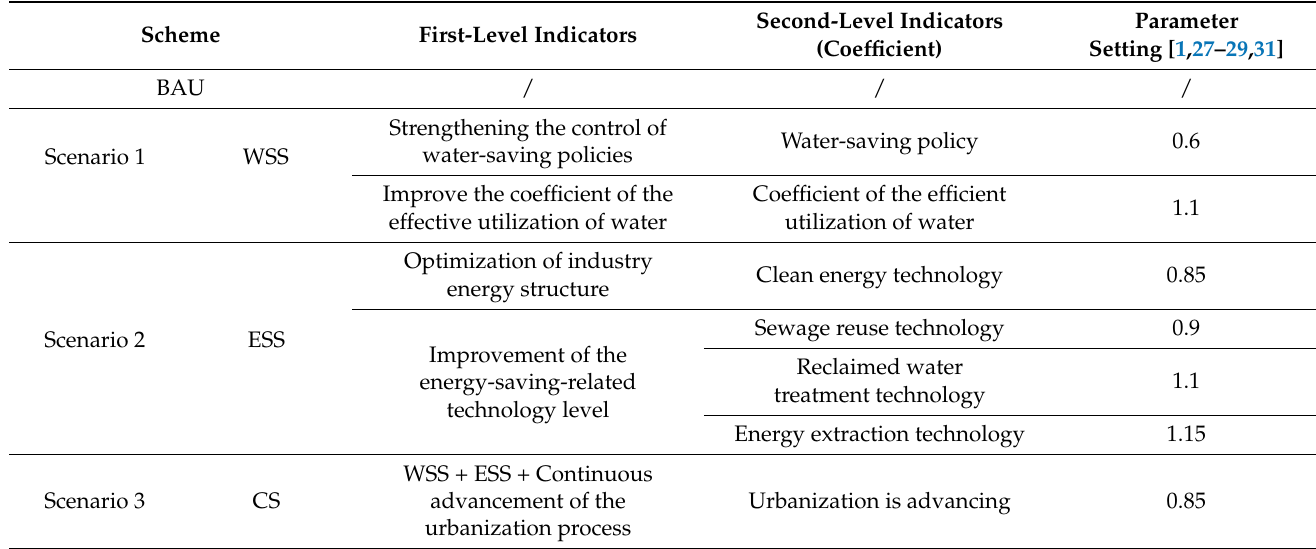
Table 6. Parameter settings of different